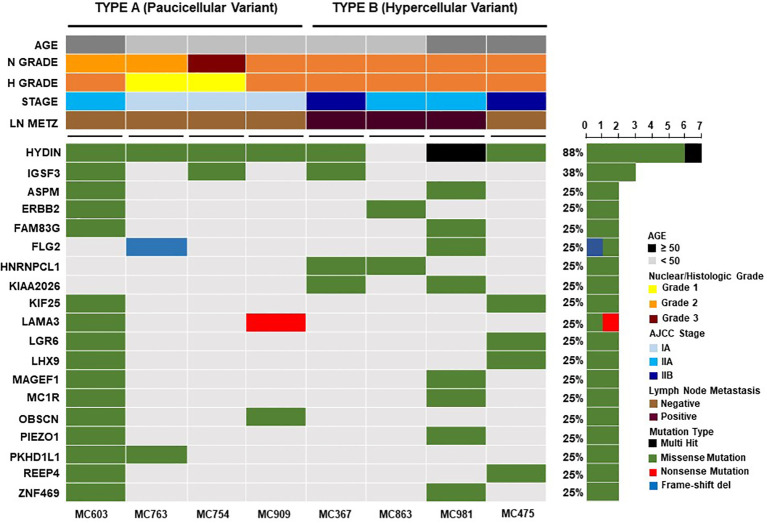
Recurrent somatic genetic alterations in mucinous breast cancers. Each column represents a sample and each row a different gene. The top barplot depicts clinicopathologic characteristics for each patient, while the right barplot shows the frequency of mutations in each gene. Genetic alterations are colored according to the variant type as indicated in the legend. Genes annotated as “Multi-Hit” have more than one mutation in the same sample.